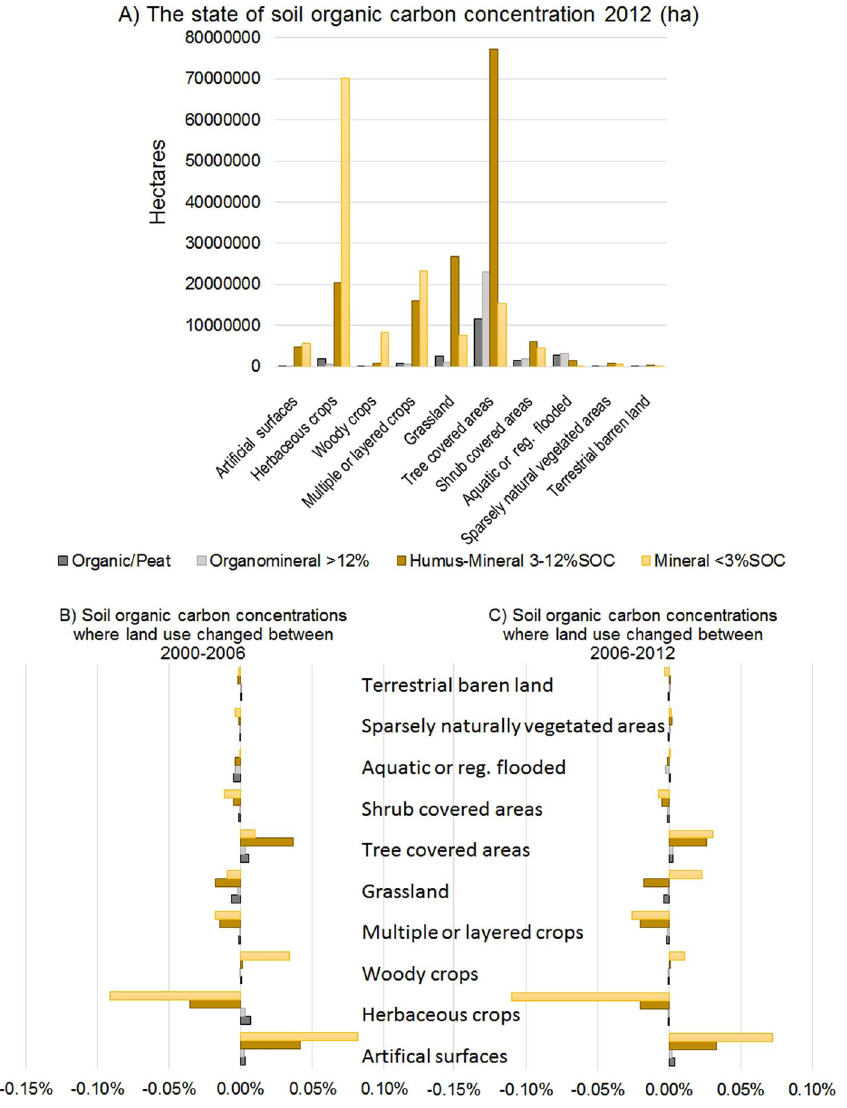
Figure 4. ( A ) The area of land with respective soil organic carbon concentration, by land use (ha) in the EU-25 study (carbon concentrations divided into 4 categories using the LUCAS data). ( B ) The soil carbon concentration of land subject to change of use between 2000 and 2006. ( C ) The soil carbon concentration of land subject to change of use between 2006 and